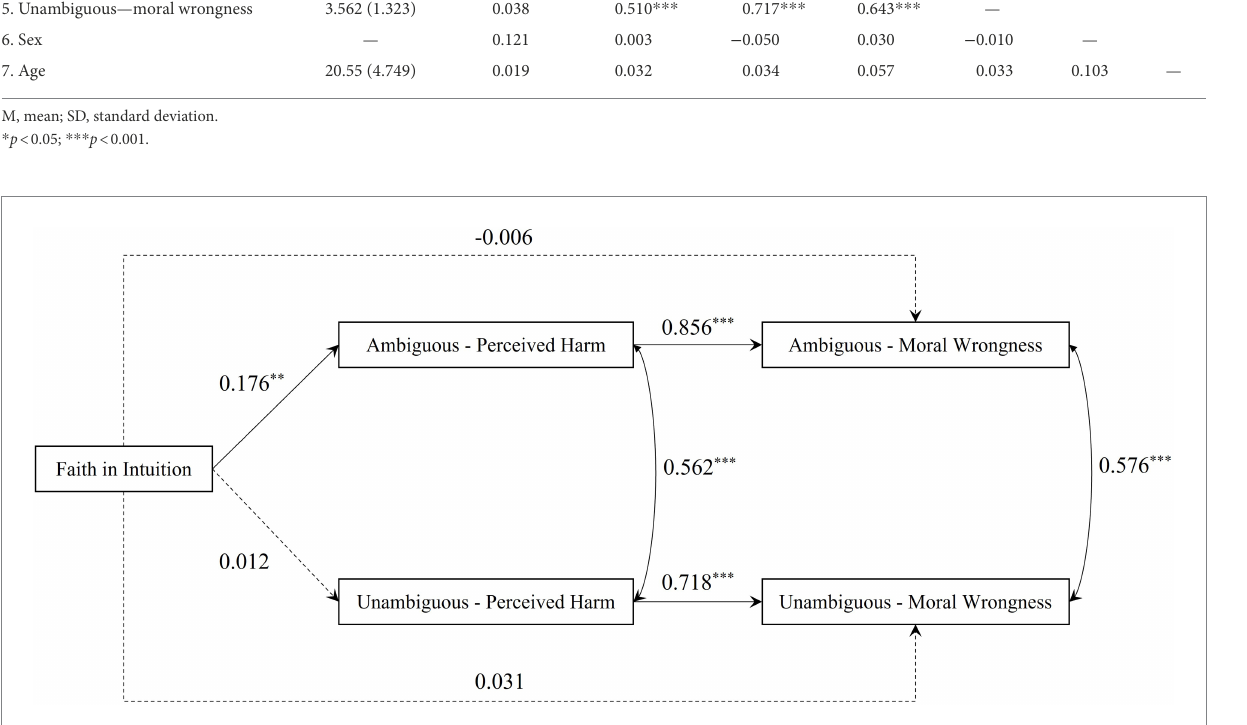
FIGURE 3 The model diagram of Experiment 2 (standardized results). ** p < 0.01, *** p < 0.001; dashed lines indicate non-significant